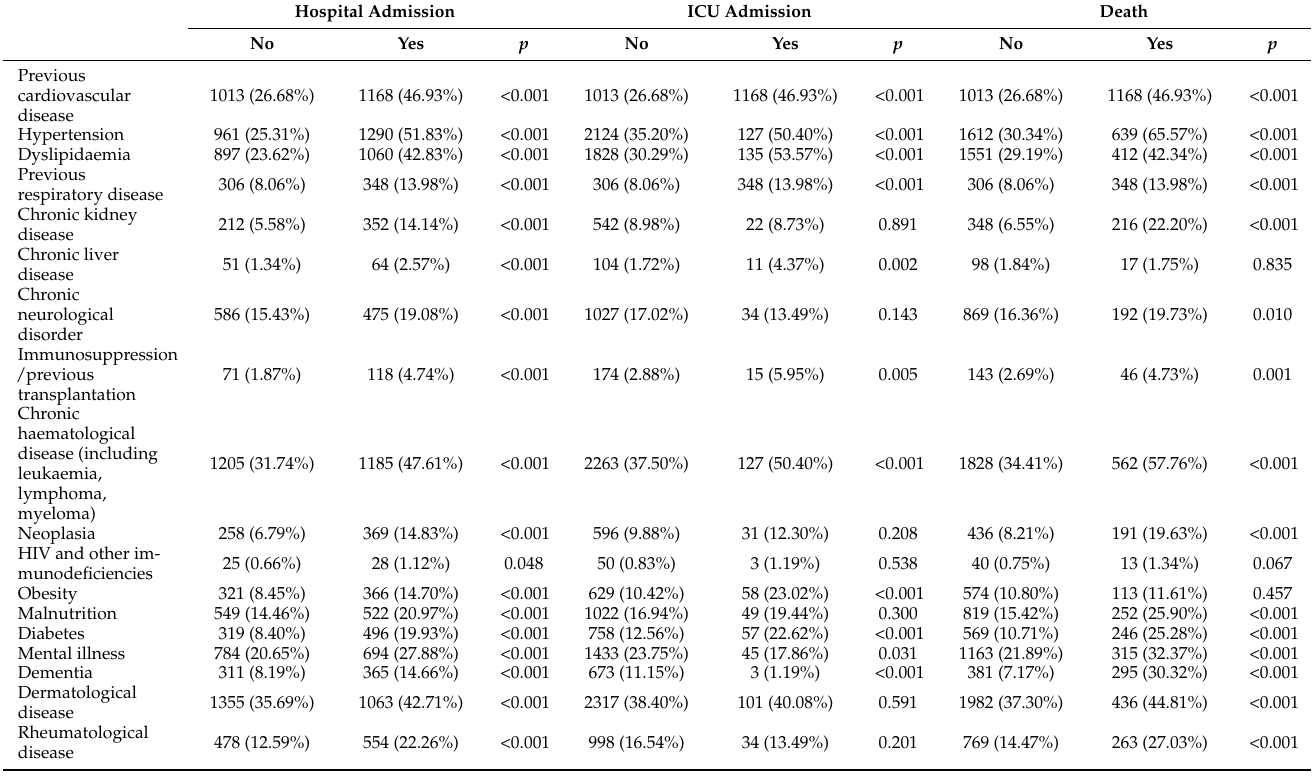
Table 2. Previous comorbidities.